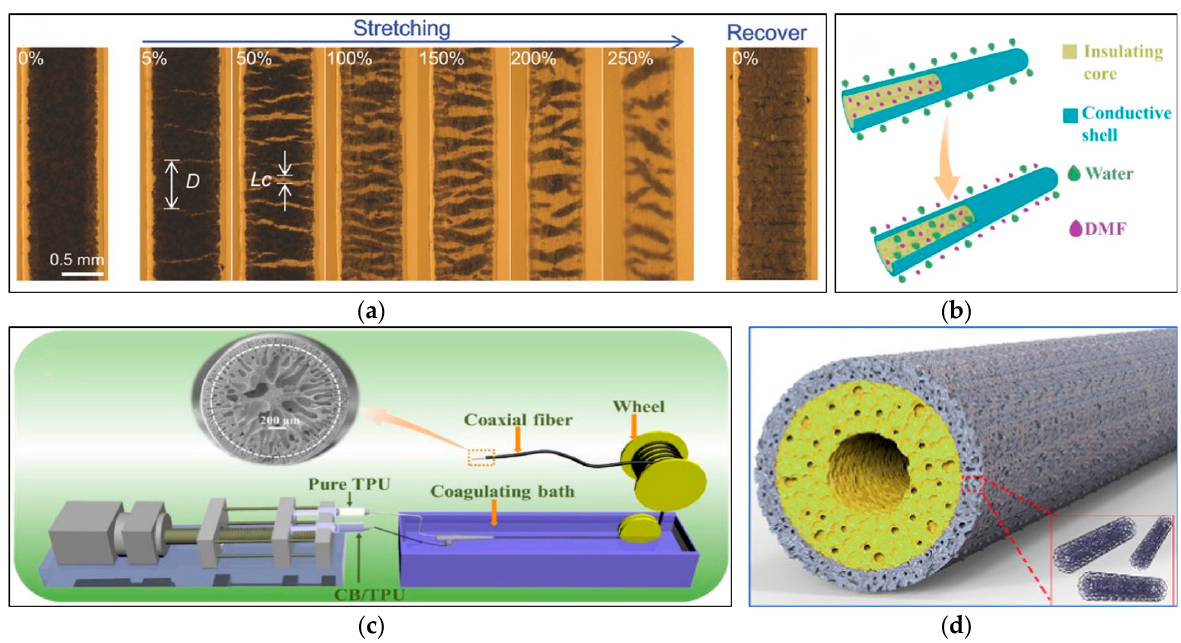
Figure 3. ( a ) The image of a typical coaxial fiber stretched from 0 to 250% strain and relaxed after unloading; D and Lc are the average crack spacing and the average crack opening displacement, respectively [38]. ( b ) Fiber cell structure evolution process ( c ) Schematic diagram of the TCTF preparation process [37]. ( d ) Schematic diagram of TPU-8CNT@TPU structure [76].